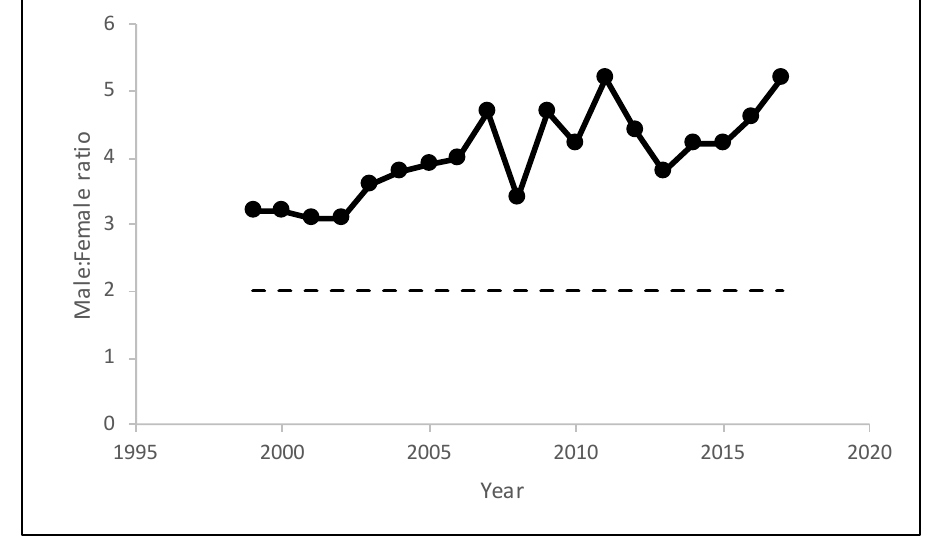
Figure 117. Sex ratio of Delaware Bay horseshoe crabs from the Delaware Bay spawning survey. The terminal year sex ratio was greater than the 2.0 reference point indicating that the male population is not overfished and there was no declining trend in the sex ratio indicating that overfishing was not